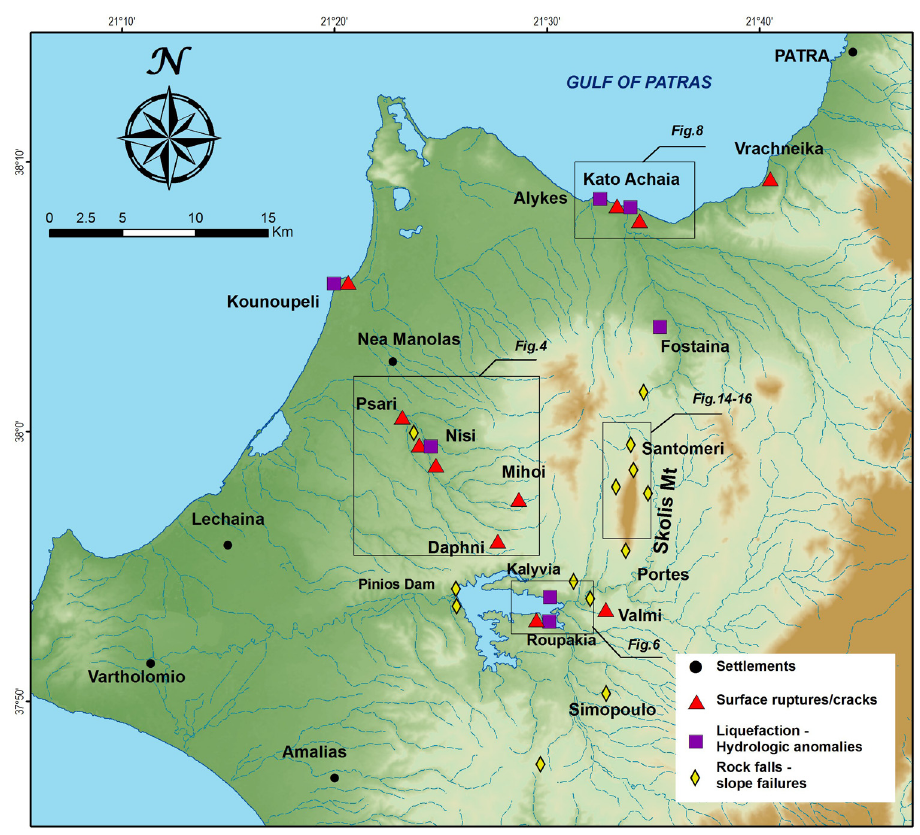
Figure 3. Ground failures triggered by the event of June 8, 2008, and mapped in the present investigation.